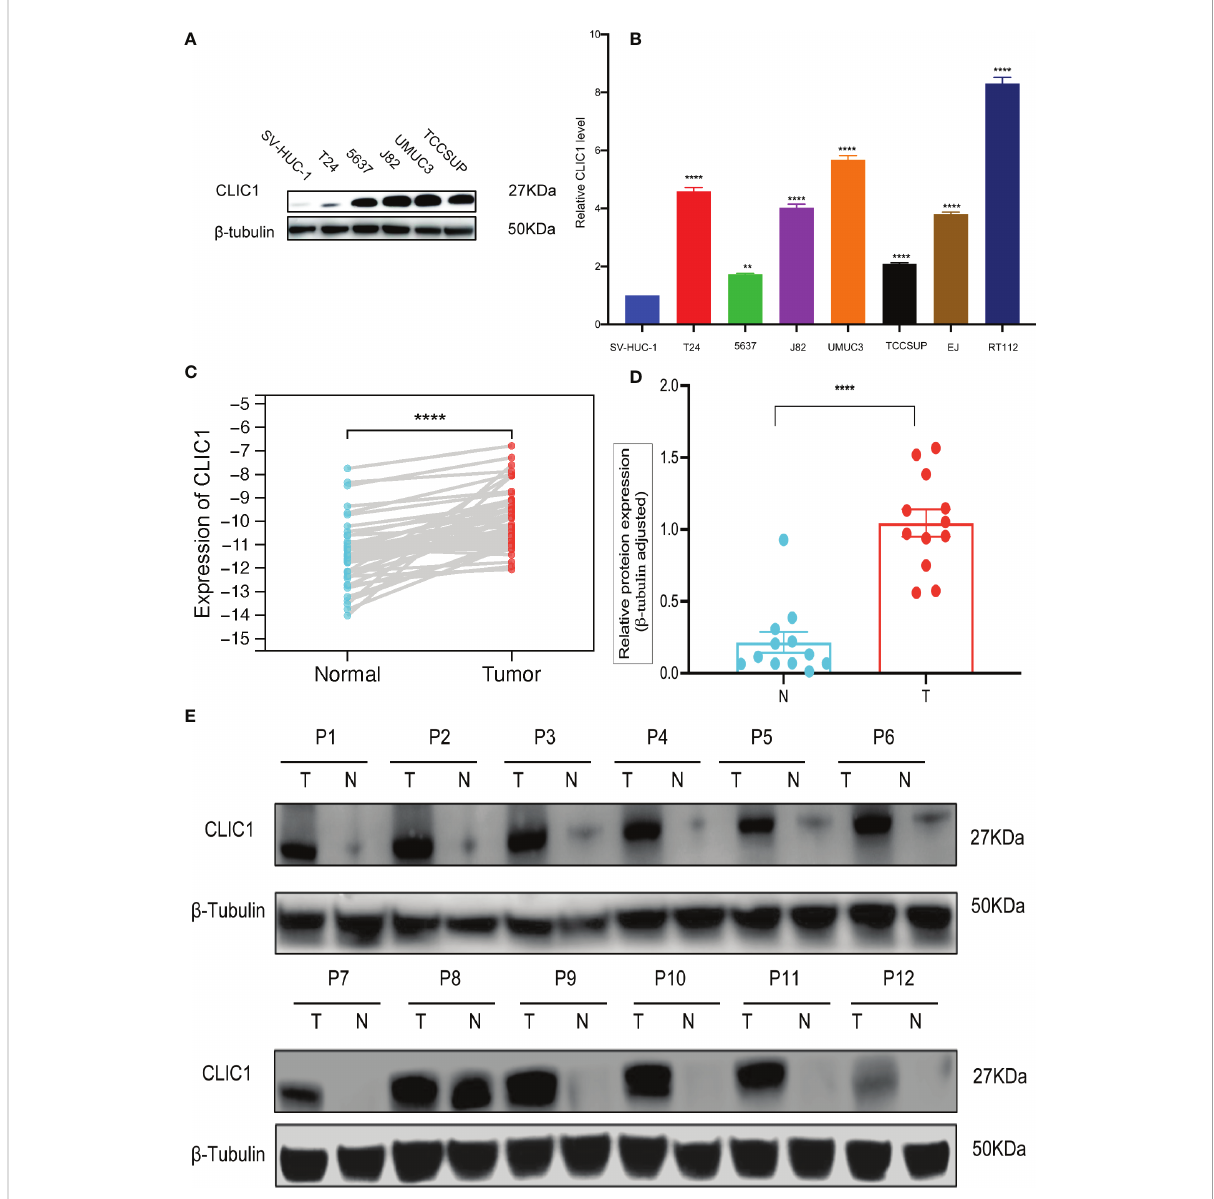
FIGURE 6 qPCR and WB analysis of CLIC1 expression in cell lines and tissues. (A) WB analysis of CLIC1 in cell lines. b -Tubulin WB was used to monitor protein loading. (B) CLIC1 mRNA expression level in SV-HUC-1 and bladder cancer cell lines. (C) CLIC1 mRNA expression level in paired primary bladder tumors and corresponding nontumor tissues. (D, E) WB analysis of CLIC1 and relative quanti fi cation. Gray value of relative expression levels of CLIC1 normalized to b -Tubulin. P < 0.05 was considered statistically signi fi cant. (**p ≤ 0.01, ****p ≤